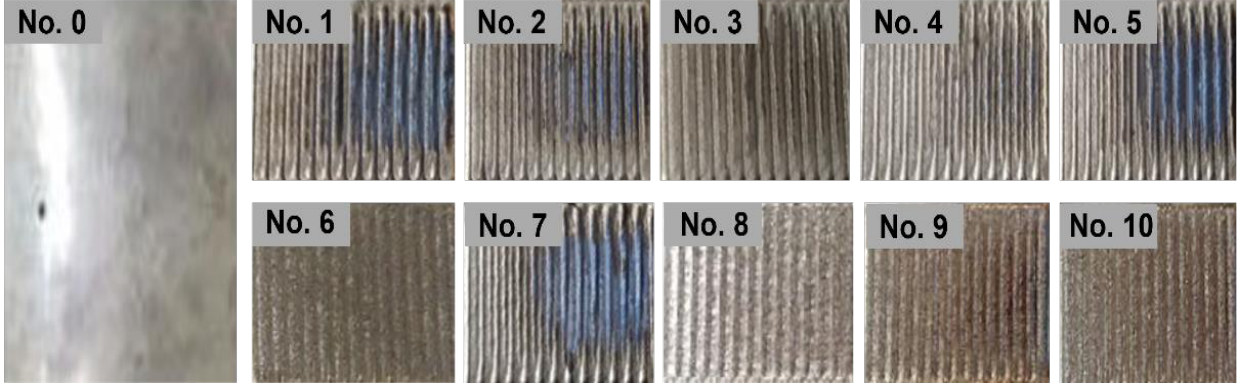
Figure 2. Laser clad coatings and the 316L stainless steel substrate. Table 3. Mass ratio of mixed powder and laser processing parameters.